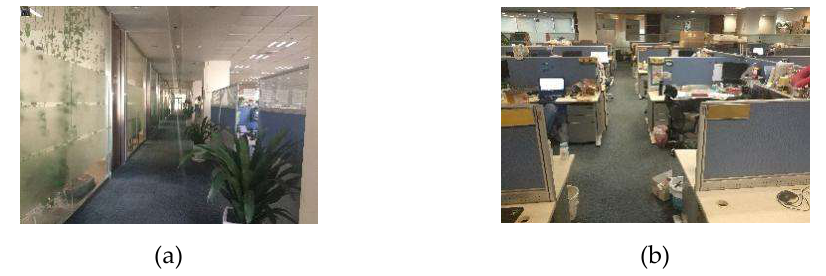
Figure 11. The experimental environment: ( a ) corridor; ( b ) work-station.